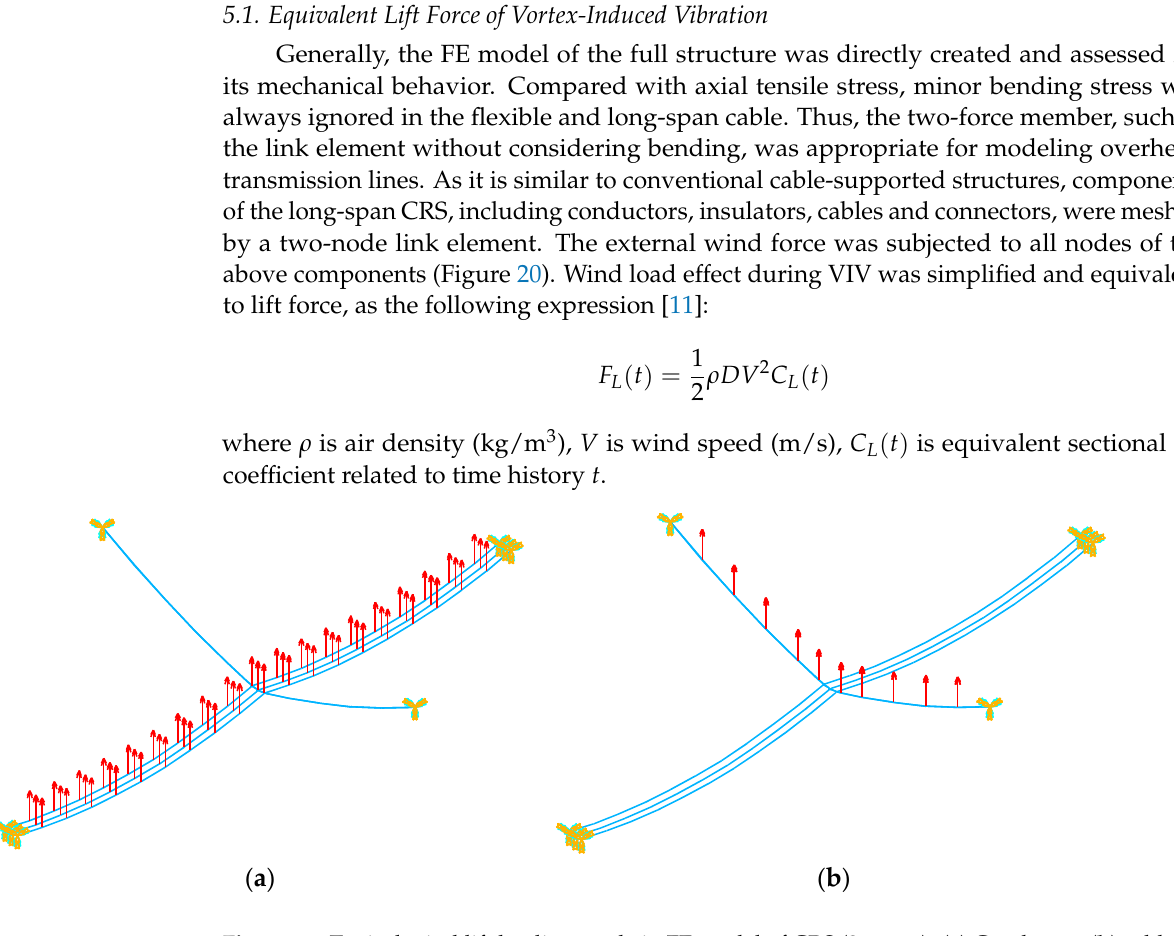
Figure 19. The influence of number of spans of conductor on maximum horizontal displacement of conductor (wind speed: 10 m/s).